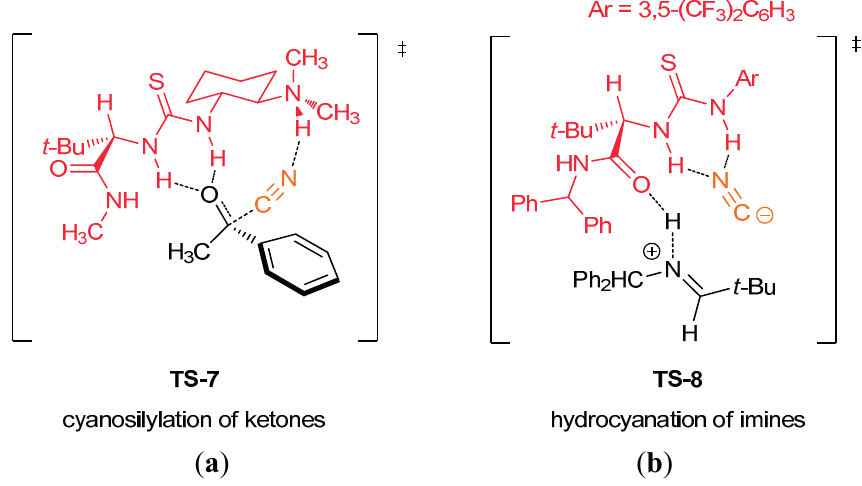
Figure 15. Transition states for the cyanosilylation of ketones ( a ); and hydrocyanation of imines ( b